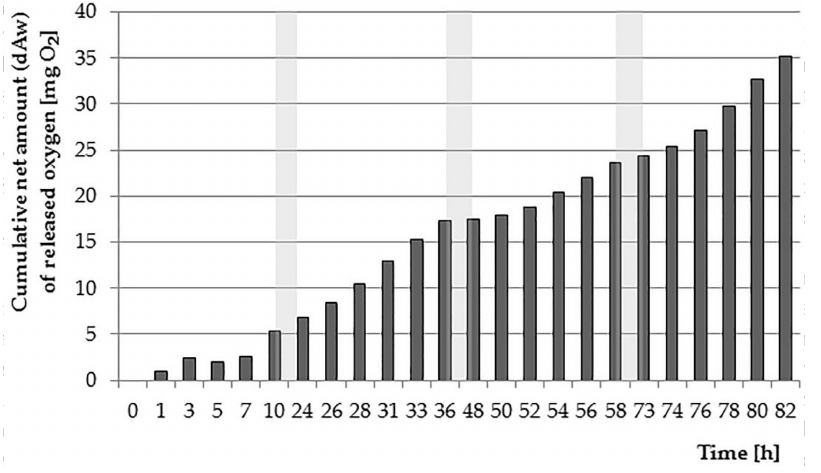
Figure 3. The cumulative net amount of oxygen dA w released into the water by E. densa (periods of nighttime—without measurements—marked as grey